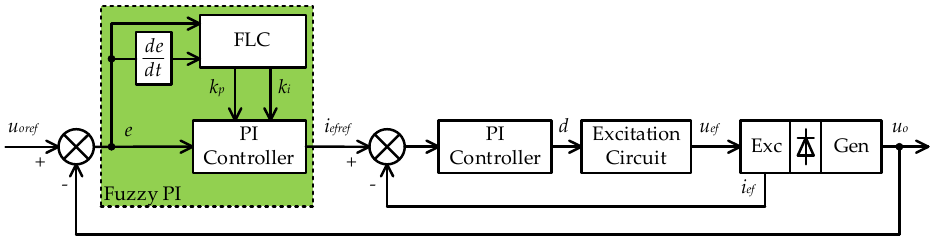
Figure 7. Block diagram of the fuzzy PI controller for the voltage regulation of the BSG.